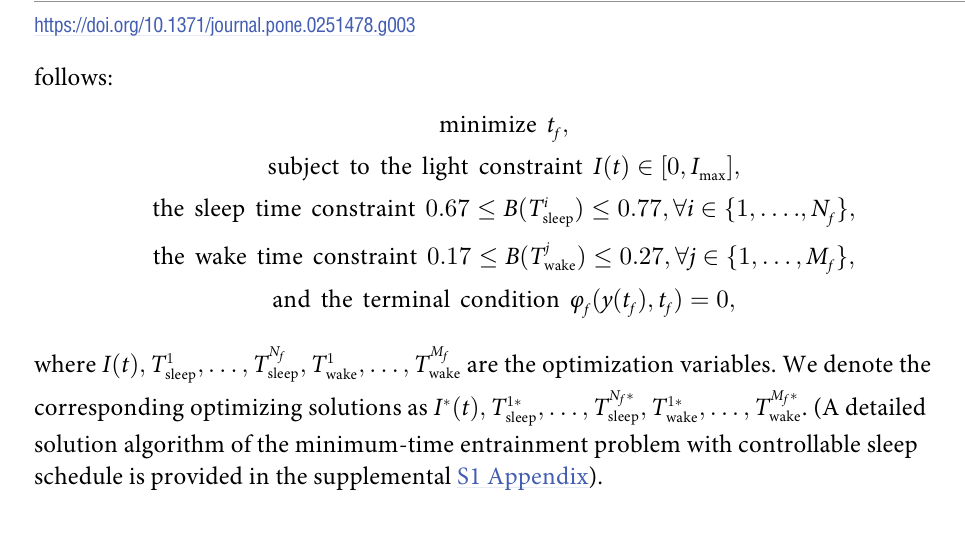
Fig 3. Illustrations of sleep state (gray region) and sleepiness (blue curve) under the controllable sleep schedule in (16) and (17). The two horizon pale red bars demonstrate the range of sleepiness that the subject could fall asleep and wake